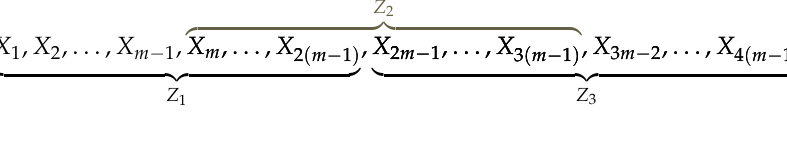
Figure 2. Construction of Z j